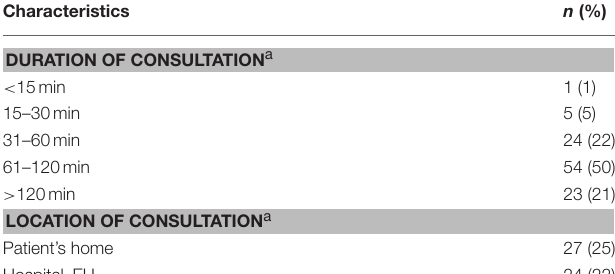
TABLE 2 | Characteristics of